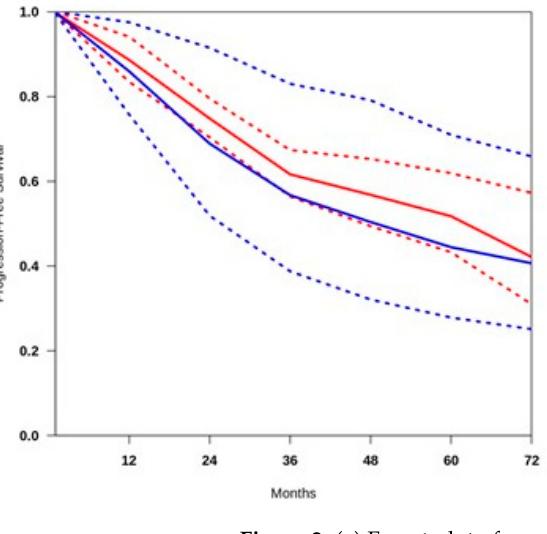
Figure 2. ( a ) Forest plot of progression-free survival hazard ratios obtained using a random model. Studies are arranged by publication year. ( b ) Curves of progression-free survival obtained using the approach of Combescure et al. with random effects. Blue lines represent the summarized disease progression curves and the 95% confidence bands (dashed lines) for control arm. Red lines represent the summarized disease progression curves and the 95% confidence bands (dashed lines) for triplet treatment.